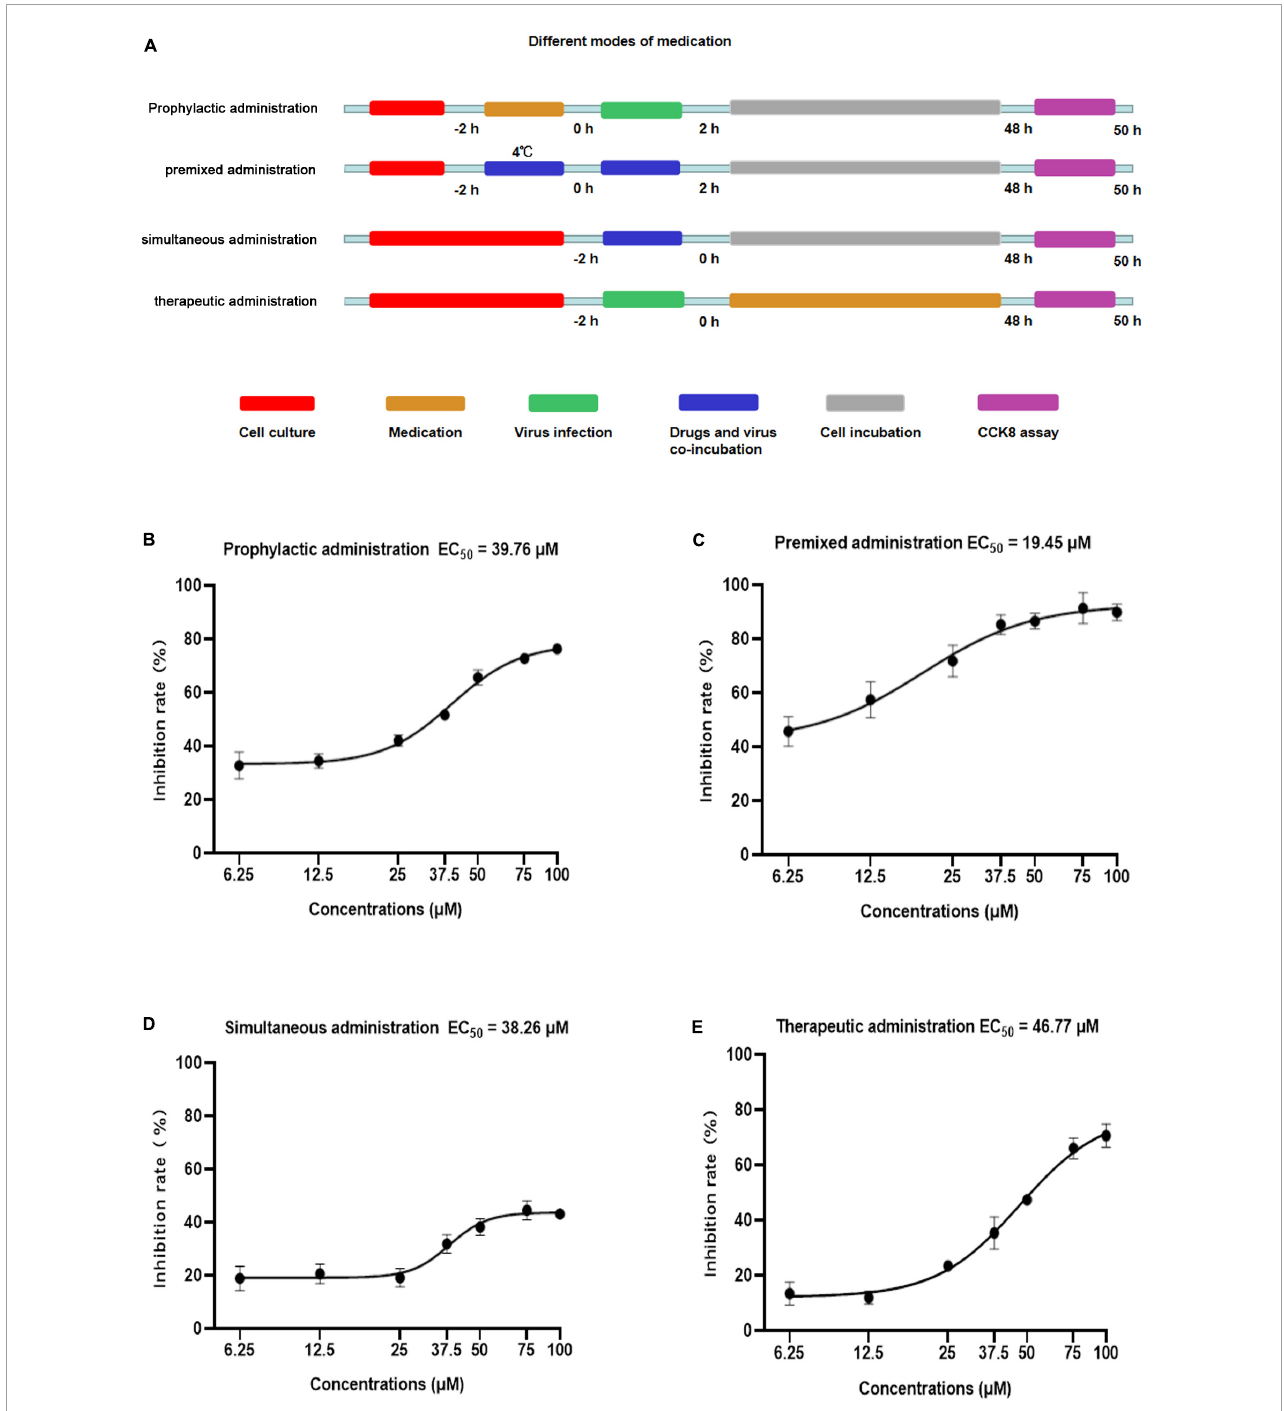
FIGURE2 Anti-viral activity of Patchouli alcohol against influenza A virus with different medication modes in MDCK cells. (A) Sketch of different medication modes. Prophylactic administration: drugs were added to the cell for incubation before the infection and the virus was added to MDCK cells. Premixed administration: drugs and viruses were mixed and incubated at 4 ◦ C for 2 h, then added the infection virus and drug mixture to MDCK cells. Simultaneous administration: drugs and viruses were mixed and immediately added the mixture to the MDCK cell. Therapeutic administration: drugs were added to MDCK cells after infection by the virus. Red: the period of cell culture; orange: the period of drug medication; green: the period of virus infection; blue: drugs and the virus in the medium at the same time; gray: cells were cultured without drugs and virus; purple: the period of detection. (B) In prophylactic administration mode, the inhibition rates of Patchouli alcohol on influenza virus A/Puerto Rico/8/34 (H1N1) strain were determined by CCK-8 assay at 48 h post-infection. (C) In premixed administration mode, the inhibition rates of Patchouli alcohol on influenza A/Puerto Rico/8/34 (H1N1) strain were determined by CCK-8 assay at 48 h post-infection. (D) Simultaneous administration mode and the inhibition rates of Patchouli alcohol on influenza A/Puerto Rico /8/34 (H1N1) strain were determined by CCK-8 assay at 48 h post-infection. (E) In therapeutic administration, the inhibition rates of Patchouli alcohol on influenza A/Puerto Rico/8/34 (H1N1) strain were determined by CCK-8 assay at 48 h post-infection. n = 3, each concentration was conducted in